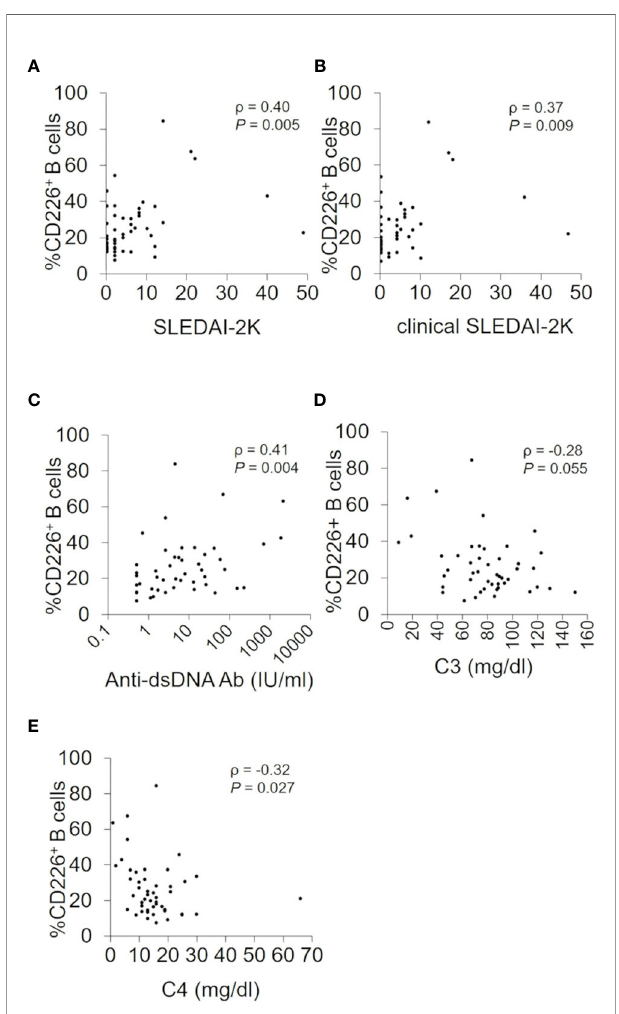
FIGURE 2 | Associations between CD226 + B cells and SLEDAI-2K, clinical SLEDAI-2K, anti-dsDNA antibody titers, serum C3, and C4 levels. Correlations between the percentage of CD226 + B cells and SLEDAI-2K scores (A) , clinical SLEDAI-2K (B) , anti-dsDNA antibody (Ab) titers (C) , the serum C3 (D) , and C4 levels (E) in SLE patients. Each data point represents a single subject. Correlation analyses were evaluated using Spearman ’ s rank correlation. SLEDAI-2K, SLE Disease Activity Index